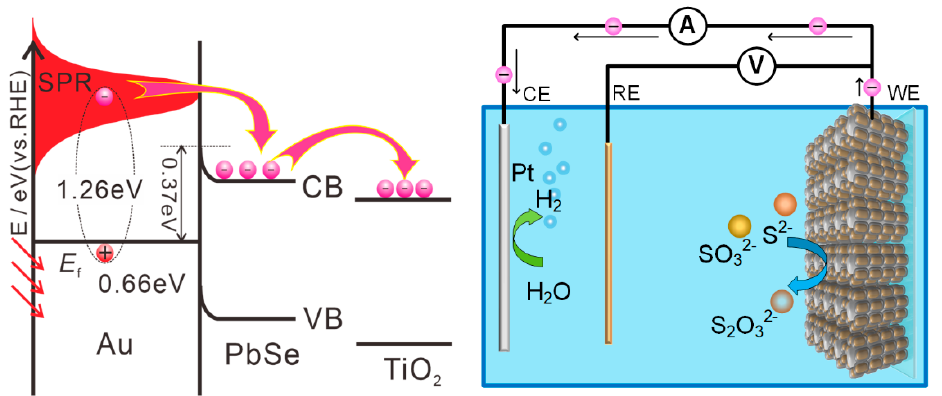
Figure 7. Schematic illustration of device configuration and proposed energy band structure mechanism of TiO 2 photoelectrode sensitized with Au–PbSe hybrid NRs.